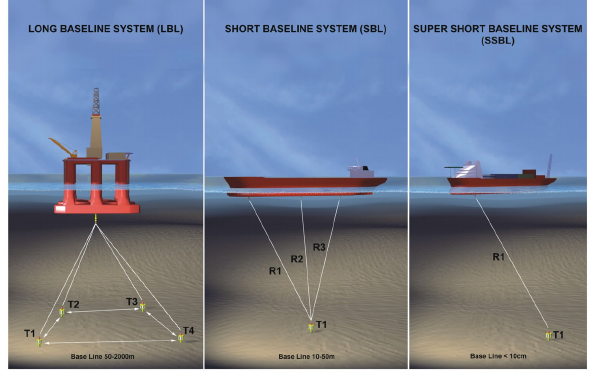
Figure 9: The acoustic positioning principles that have been used. LBL has advantages in very deep water, since its accuracy is independent of water depth. Illustration: